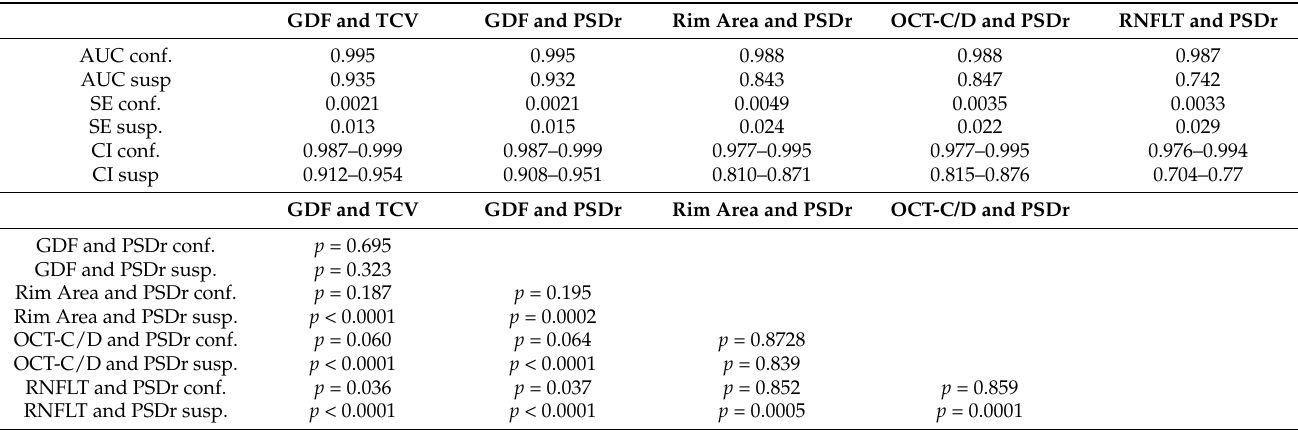
Table 4. Performance of the combination of Laguna ONhE and Cirrus-OCT variables and perimetric variables between reference and confirmed (conf.) and suspect (susp.) glaucoma cases. GDF and TCV GDF and PSDr Rim Area and PSDr OCT-C/D and PSDr RNFLT and PSDr AUC conf. 0.995